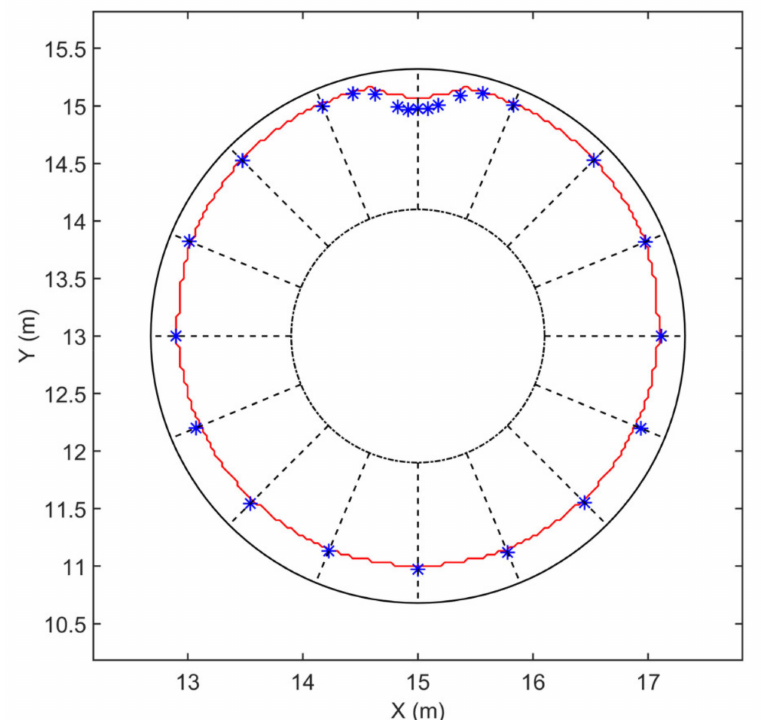
Figure 8. Comparison between the maximum computed and measured runup heights (A/h = 0.091). Both numerical results and measured data are projected onto the circular island. Note that the incident solitary wave propagates along the + y -direction from the bottom boundary. The red line shows the computed maximum runup heights; the blue asterisks indicate the measured runup